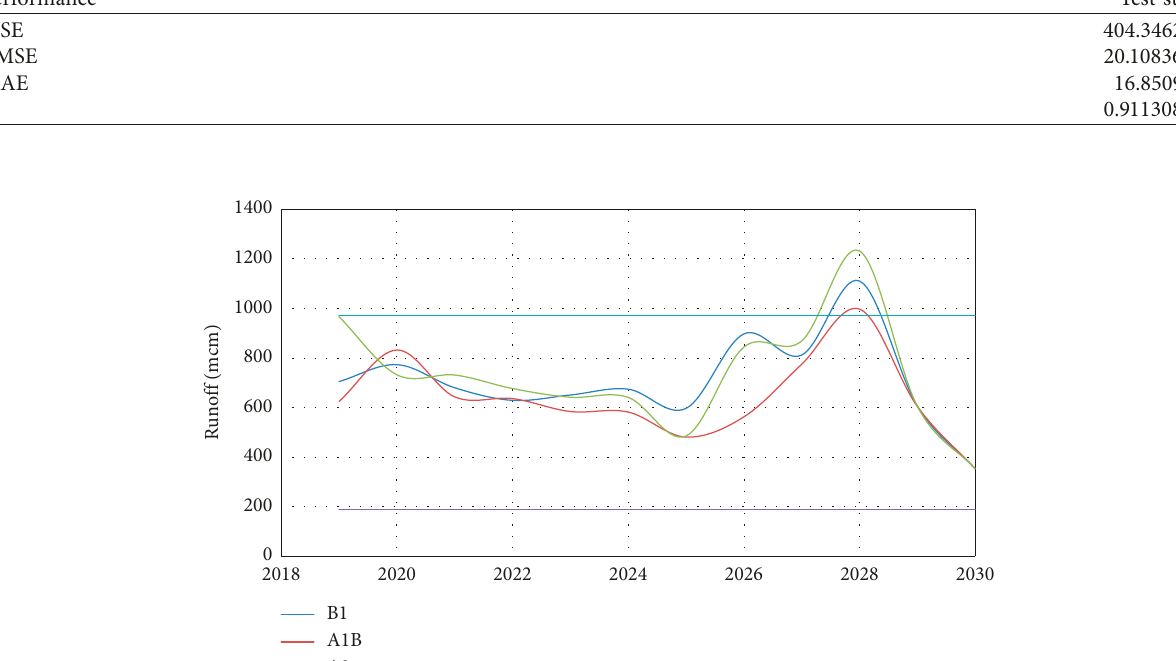
Figure 13: Observational runoff—monthly simulation of the Doroudzan dam in the neural network test step. R � the observational runoff; R � output the runoff simulated by the neural network. Table 9: Performance of the neural network for the monthly rainfall-runoff in the Doroudzan dam in the test step. Performance